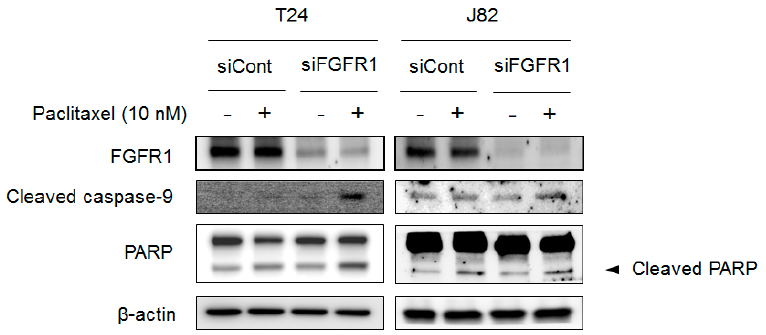
Figure 8. FGFR1 knockdown sensitizes mesenchymal-type UC cells to PTX-induced DNA damage. Expression levels of pro-apoptotic proteins including caspase-9 and cleaved PARP in T24 and J82 cell lines were evaluated by Western blotting.